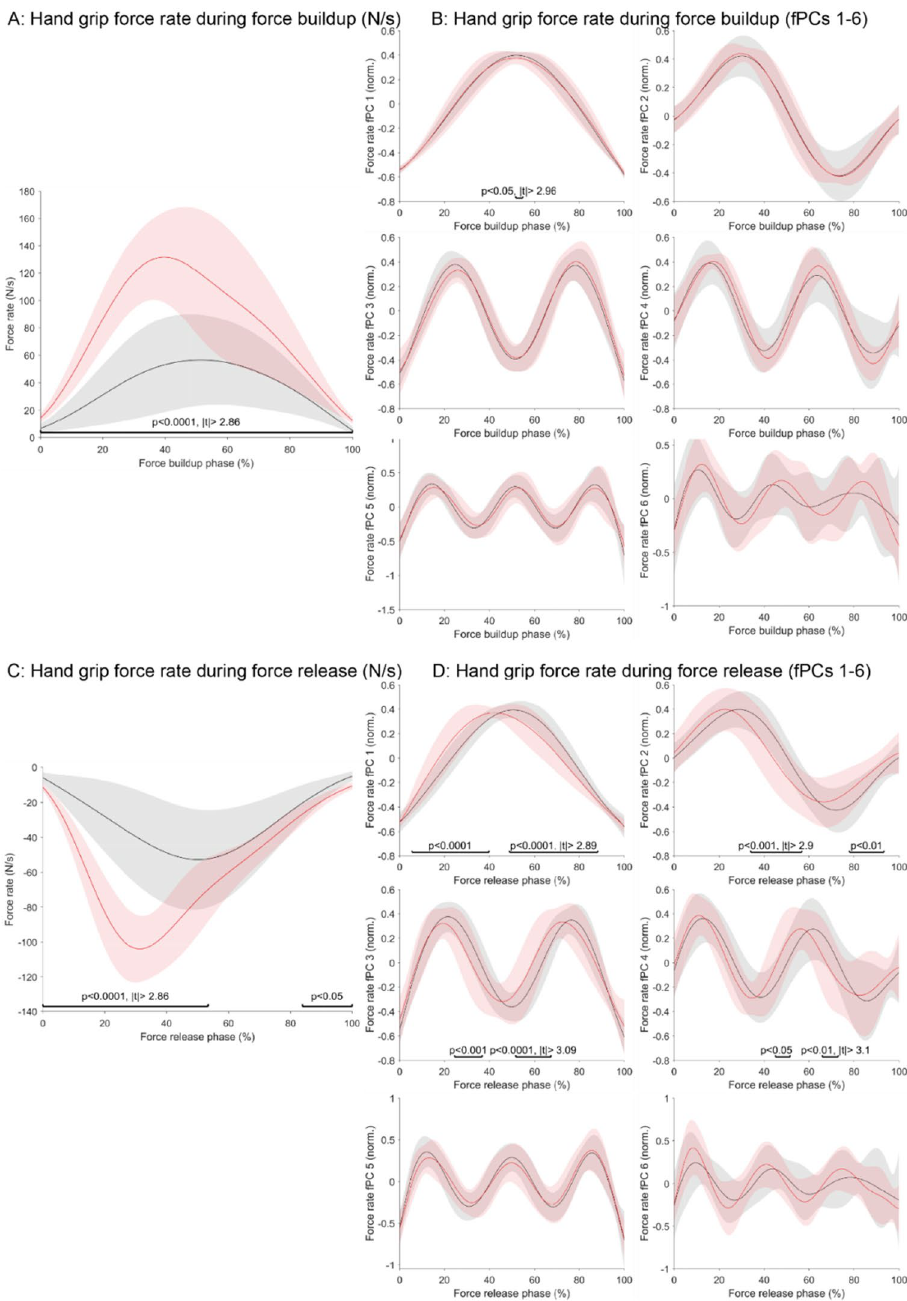
Figure 3. Grip force coordination during the force buildup and the force release phases of the functional task. The preprocessed end-effector grip force rate signals during buildup ( A ) and release ( C ) phases were visualized for the paretic side of post-stroke subjects (red) and a healthy age-matched control population (gray). In addition, the shapes of the fPCs for the buildup ( B ) and the release ( D ) signals were visualized. The time- series of the stroke and control population were compared using statistical parametric mapping and the P - and t-values of significant periods